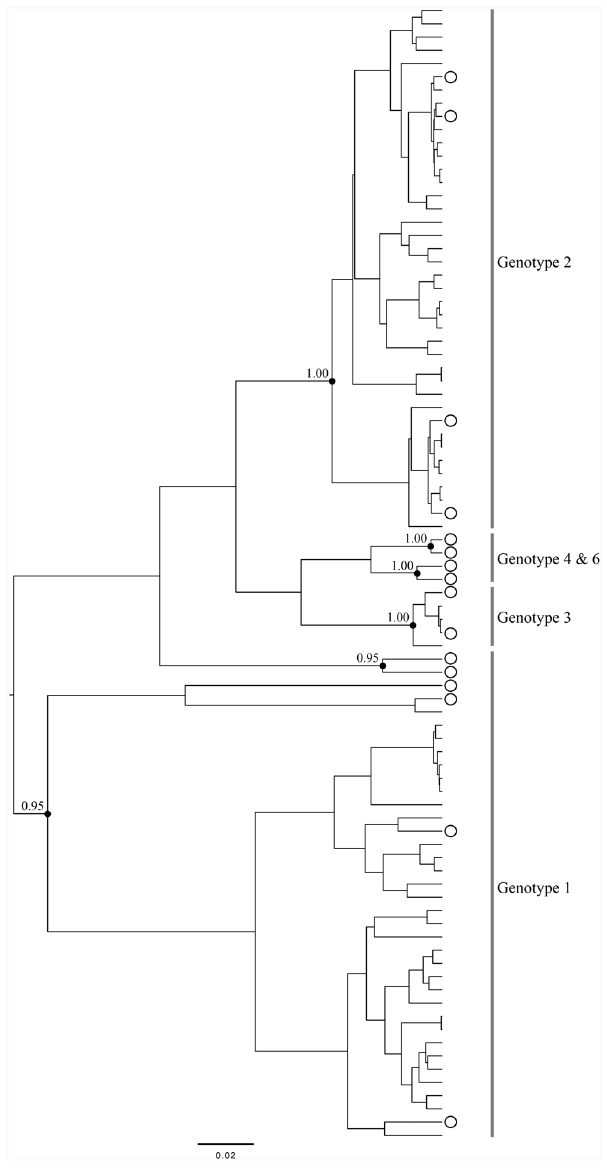
Fig. 1. Phylogenetic tree based on consensus 5 9 UTR sequences for 70 HIV/GBV-C co-infected women. GenBank reference sequences are indicated by open circles. Relevant posterior probabilities (out of 1.00) are shown. The scale bar indicates 0.02 nucleotide substitutions per